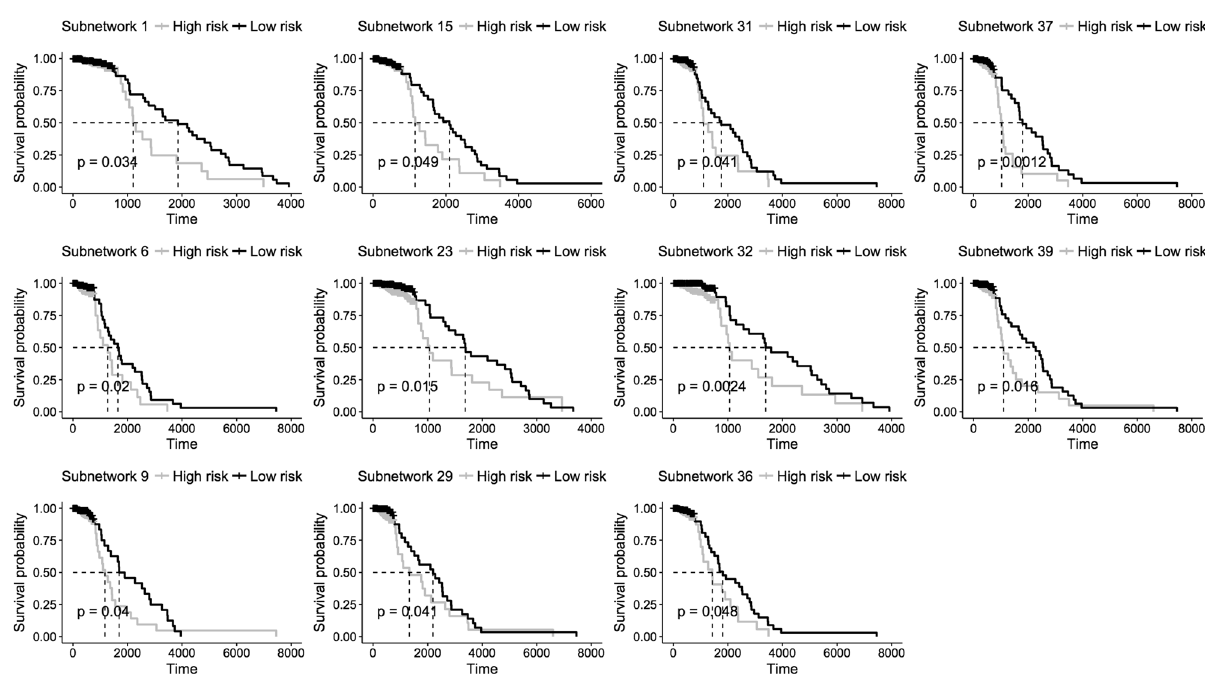
Figure 7. Kaplan–Meier survival analysis for patients in epigenetic